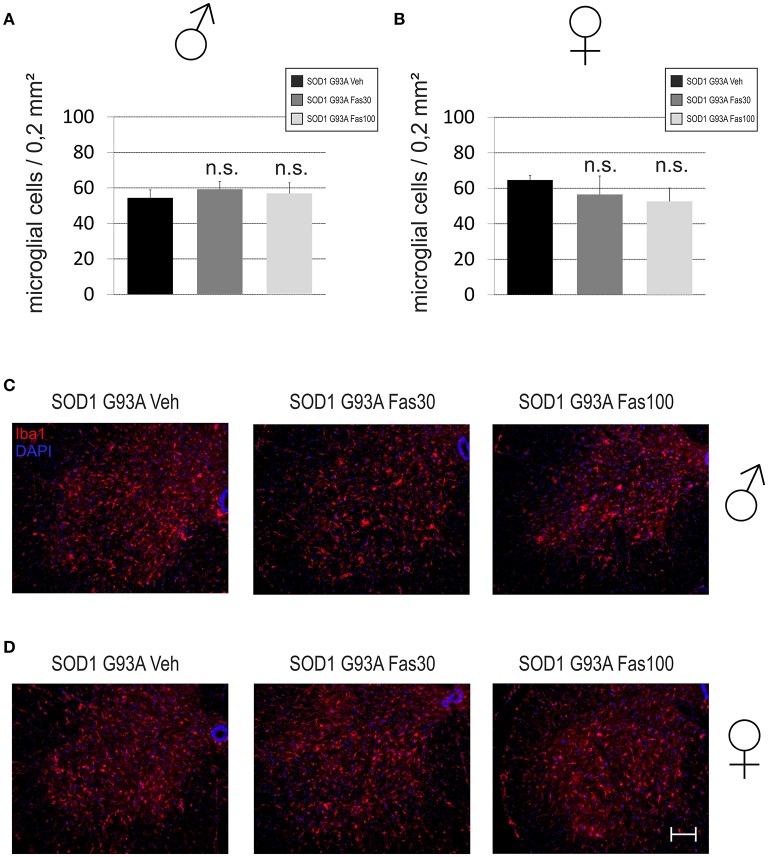
Infiltration of microglial cells in the lumbar spinal cord anterior horn in end-stage stage SOD1G93A mice. (A,B) Numbers of Iba1-immunopositive microglia (MG) per section in the spinal cord anterior horn of female (Fas30 n = 3, Fas100 n = 3, Veh) (A) and male (Fas30 n = 3, Fas100 n = 3, Veh) (B) mice treated with 30 mg/kg Fasudil (Fas30), 100 mg/kg Fasudil (Fas100), or with vehicle (Veh). (C,D) Representative micrographs of Iba1-immunopositive MG in spinal cord anterior horn of female (C) and male (D) mice. [Iba1/Cy3 (red), DAPI (blue)]. Bars represent means ± SEM. Scale bar: 100 μm.